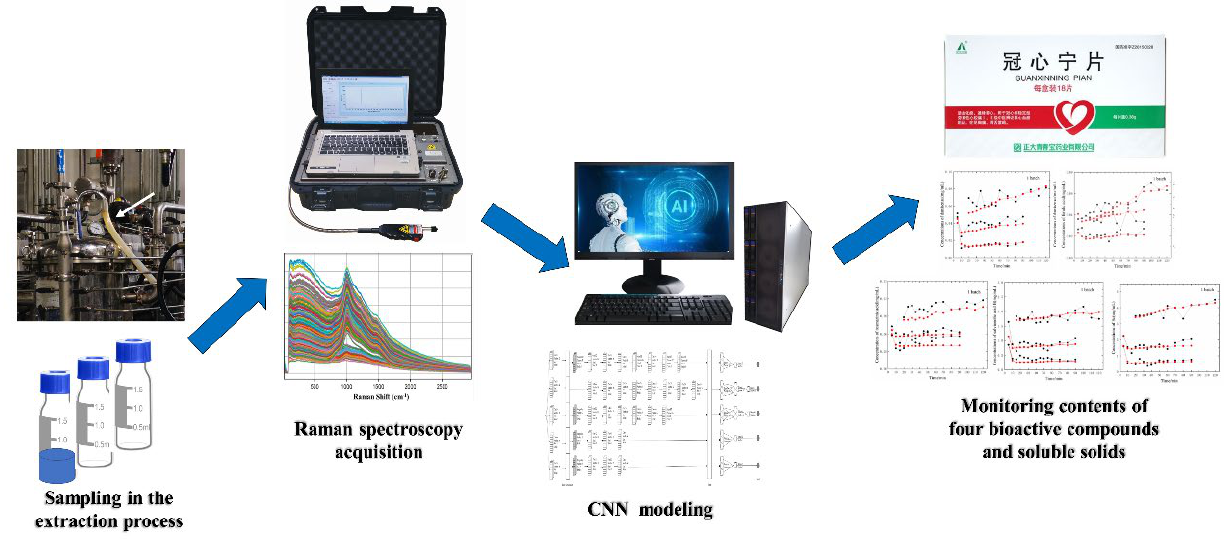
Figure 8. Schematic representation of the convolutional neural network enabled intelligent Raman spectroscopy methodology for monitoring the contents of four bioactive compounds and soluble solids in the water extracts of Guanxinning tablets.